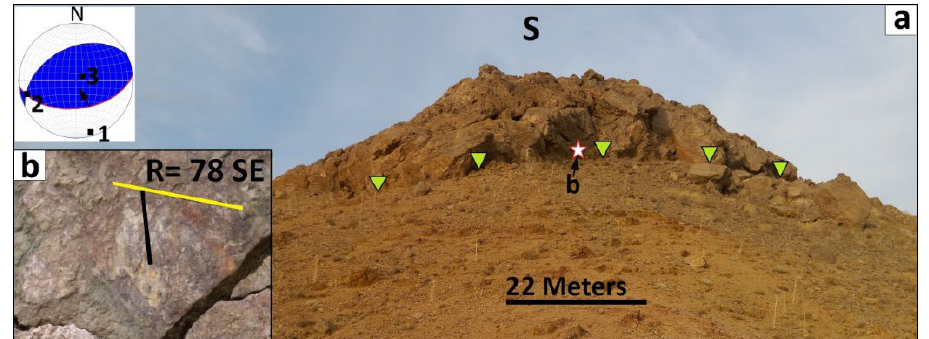
Figure 6. ( a ) Field photo of F2 fault trace (shown by triangles) that is reverse with a dextral strike- slip mechanism; ( b ) slicken line on the minor fault (the location is shown by the star). Numbers 1, 2, and 3 in the stereonet denote the orientation of the principal stress axes; the arrow in the stereonet indicates the movement direction of the hanging wall. the movement direction of the hanging